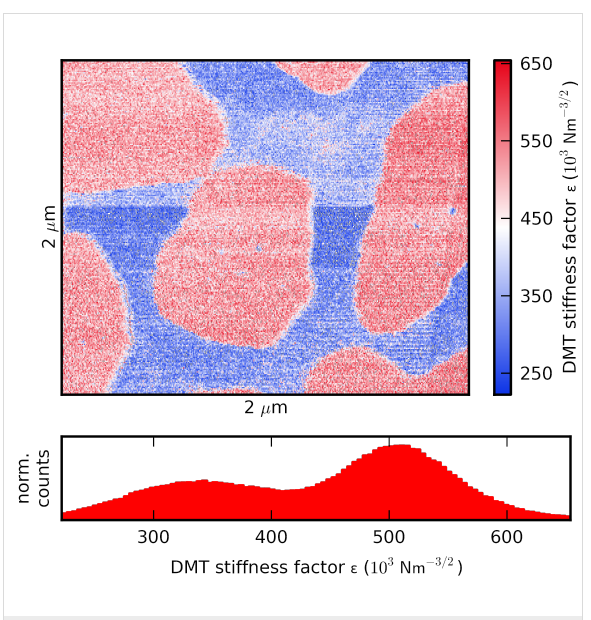
Figure 4: A surface property map showing the DMT stiffness factor ε [N m –3/2 ] with a histogram of the stiffness